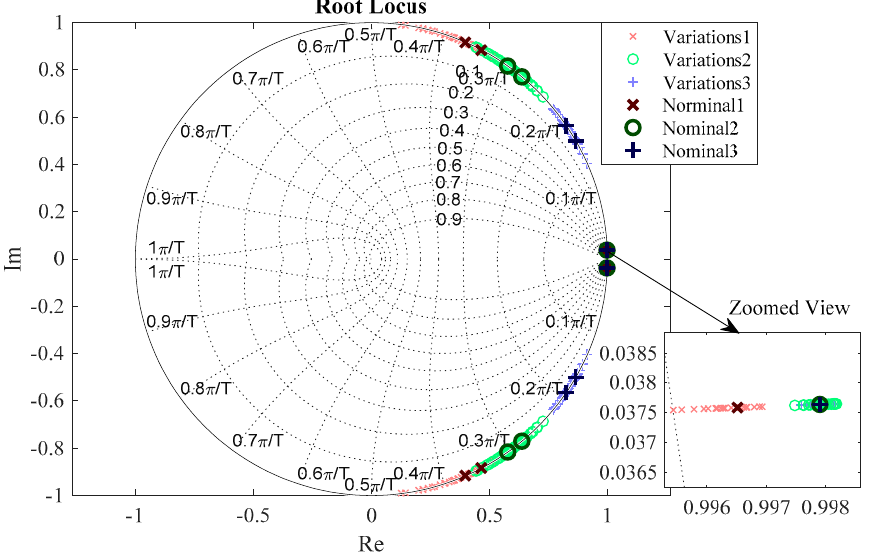
Figure 9. Eigenvalues of nominal G 1 (z), G 2 (z), and G 3 (z) and their variations.